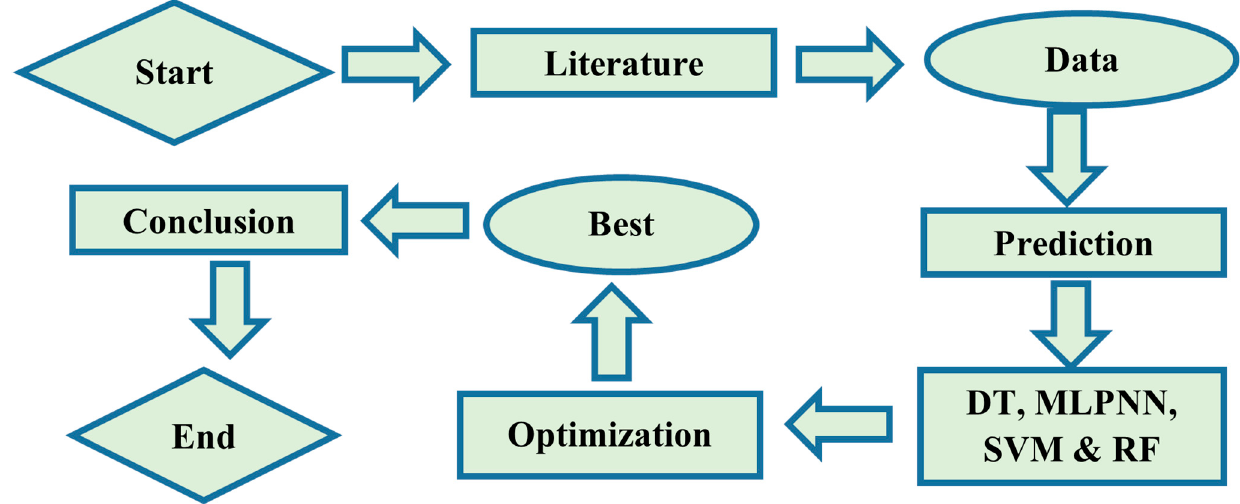
Figure 5. Flow chart of ML techniques .